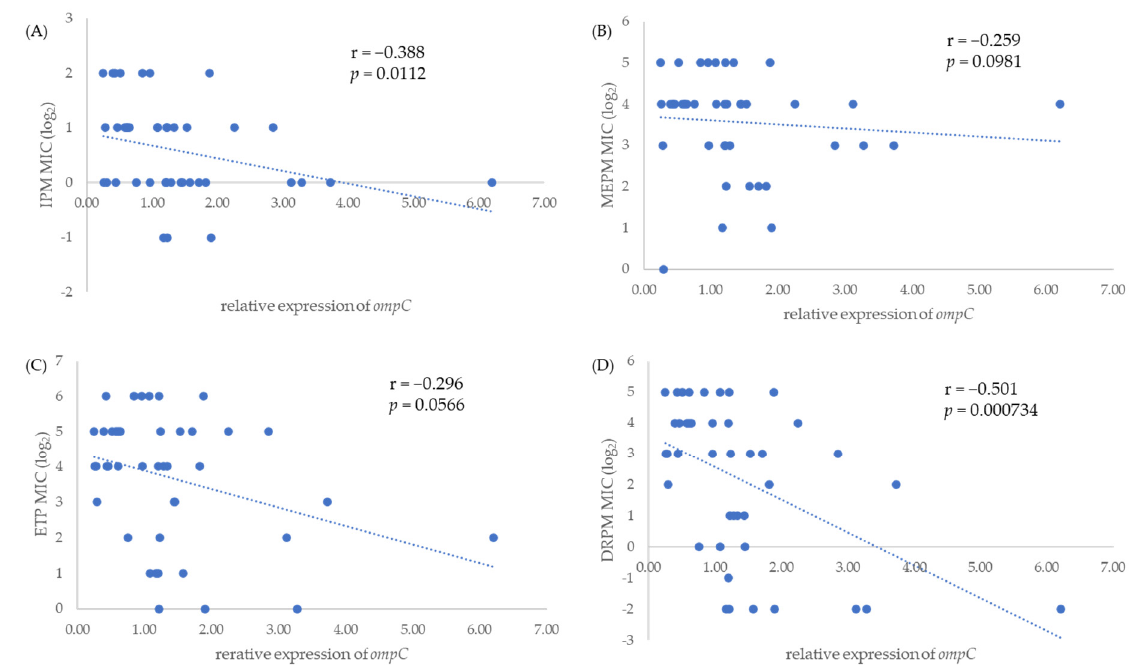
Figure 1. Correlation between relative expression levels of ompC and MICs of four carbapenems, IPM ( A ), MEPM ( B ), ETP ( C ), and DRPM ( D ), among IMP-6-producing E. coli strains.